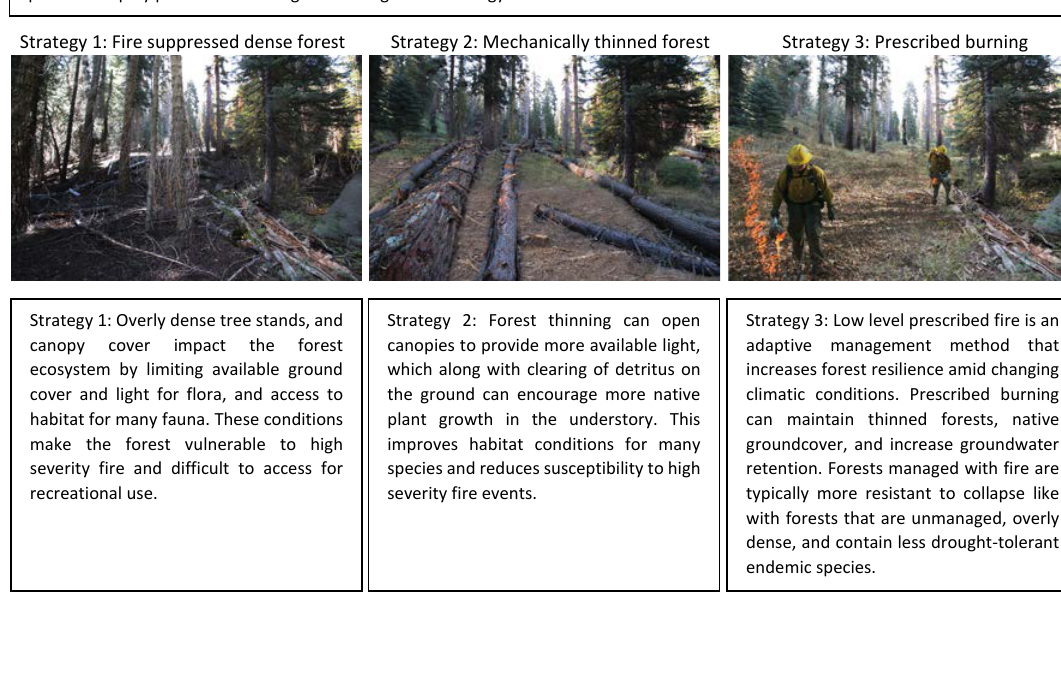
Fig. A1.7 - Site 7: Railroad Fire near Sugar Pine